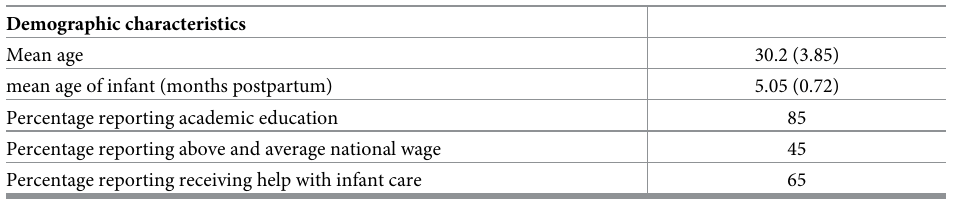
Table 1. Demographic characteristics of